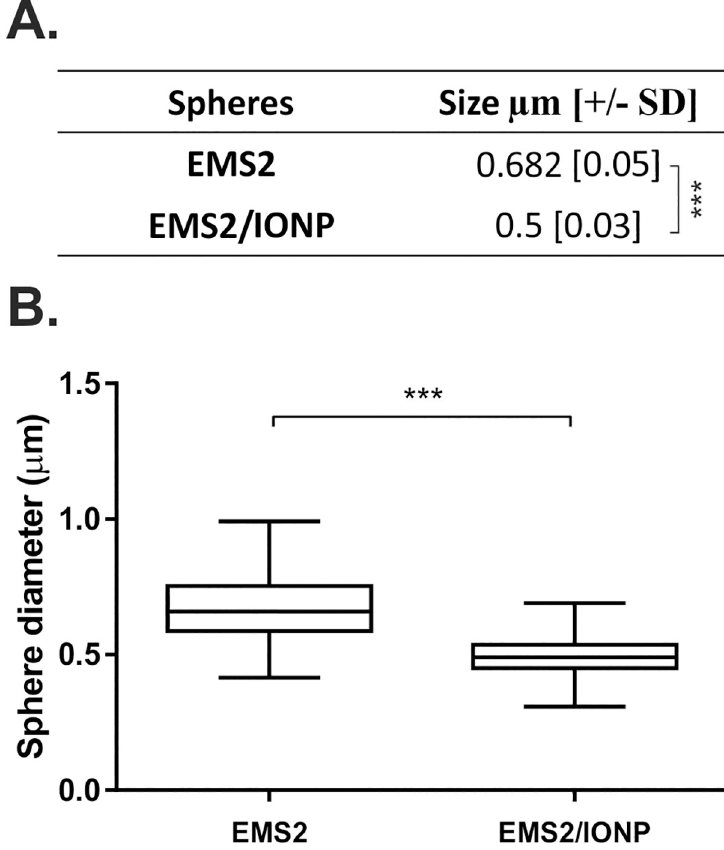
Fig 3. Size analysis of the EMS2 and EMS2/IONP spheres. For the A) size and B) size distribution analyses, the spheres were prepared by mixing a silk solution (1 mg/mL) and iron oxide nanoparticles (5 mg/mL) with 2 M potassium phosphate at pH 8. B) Whiskers show the minimal and maximal sizes of the spheres, and the line inside the box shows the median size. ��� indicates statistical significance with p <